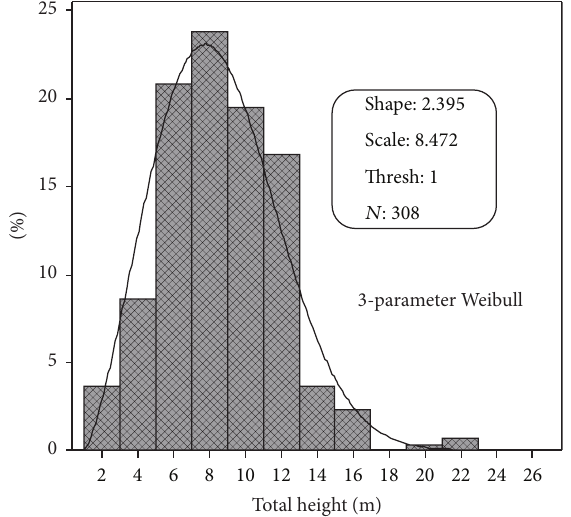
Figure 3: Diameter class-size distribution in the Sudano-Guinean zone.